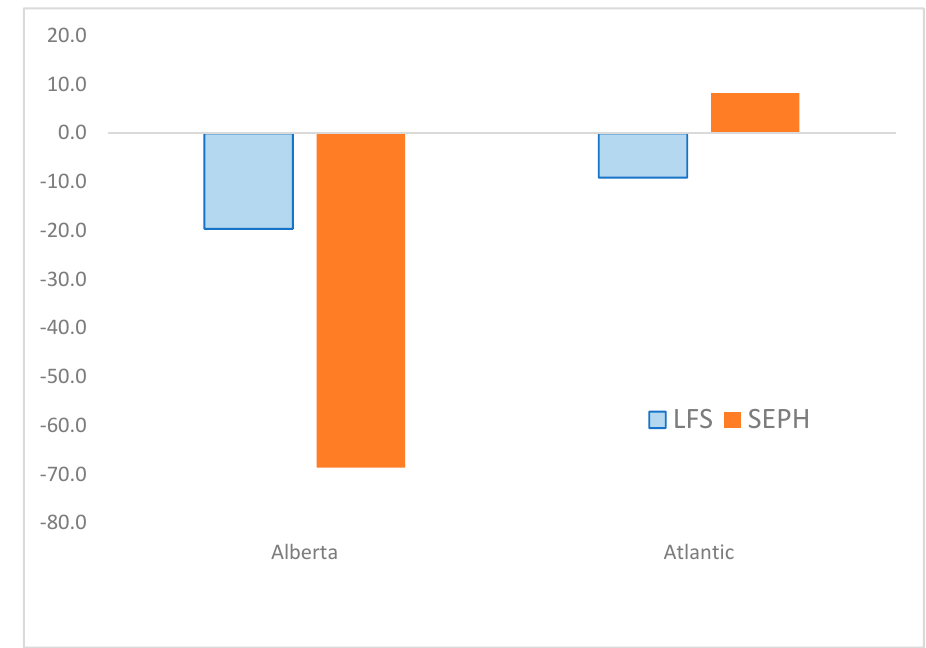
Figure 6. Change in Employment (persons X 1000), SEPH vs. LFS, December 2014–December 2015. Adapted from: Parsons, M. (2015); Source: Statistics Canada. Table 281-0049—Survey of Employment, Payrolls and Hours (SEPH) and Statistics Canada. Table 282-0087–Labour force survey estimates (LFS). [33].